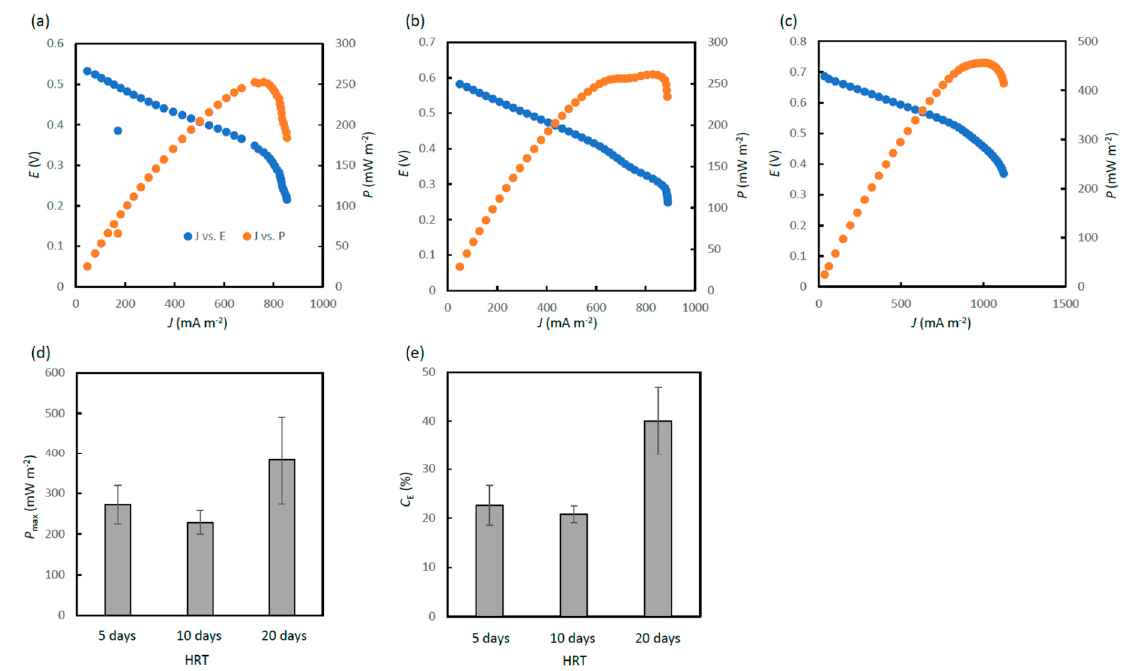
Figure 2. Power generation by ADE-treating MFCs operated at HRTs of 5, 10 or 20 days. Representative polarization and power curves for MFCs operated at HRTs of 5, 10 and 20 days are shown in ( a ), ( b ), and ( c ), respectively. ( d ) Comparison of P max values for MFCs operated at the different HRTs ( R ext was 500 Ω ). (e) Comparison of C E values for MFCs operated at the different HRTs ( R ext was 500 Ω ). In (d) and (e), mean values and standard errors are shown (n = 9).